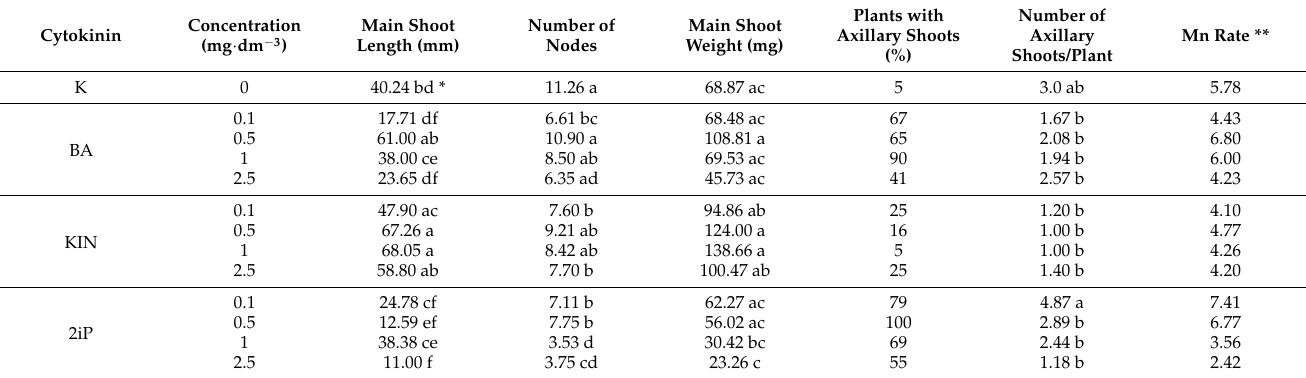
Table 4. Regeneration and multiplication of S. mytilloides shoots in tissue culture depending on the cytokinins content in the media.